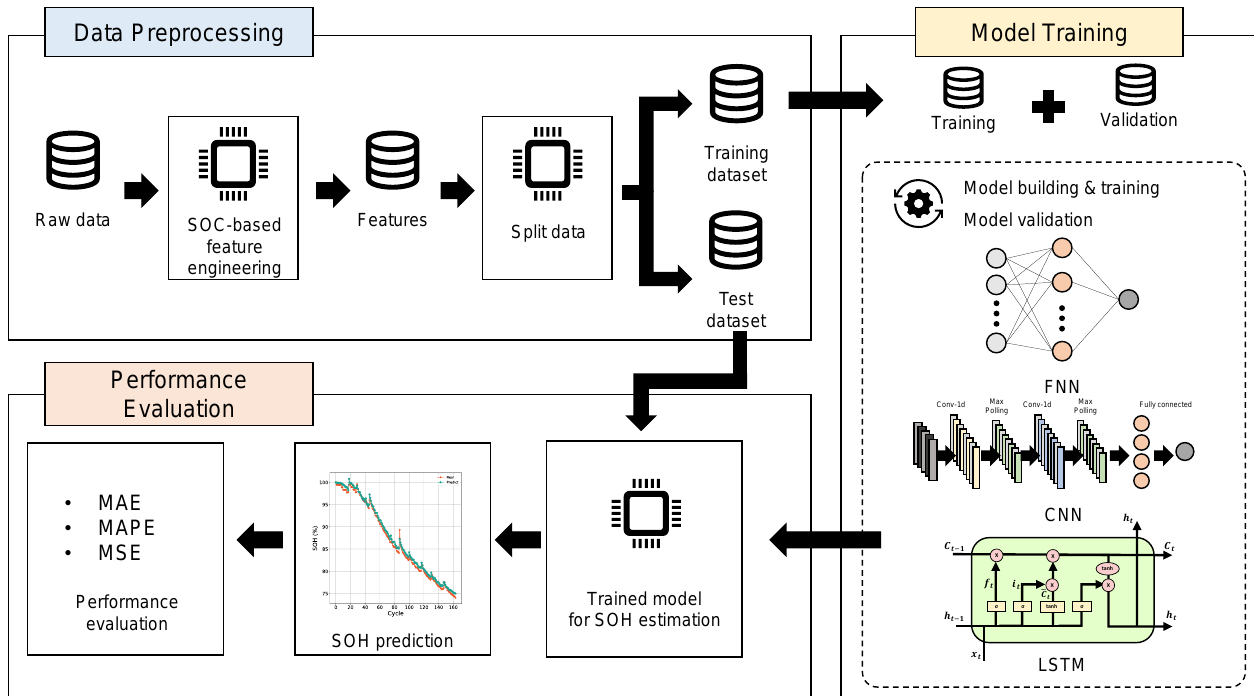
Figure 5. Overview of the proposed process for battery capacity